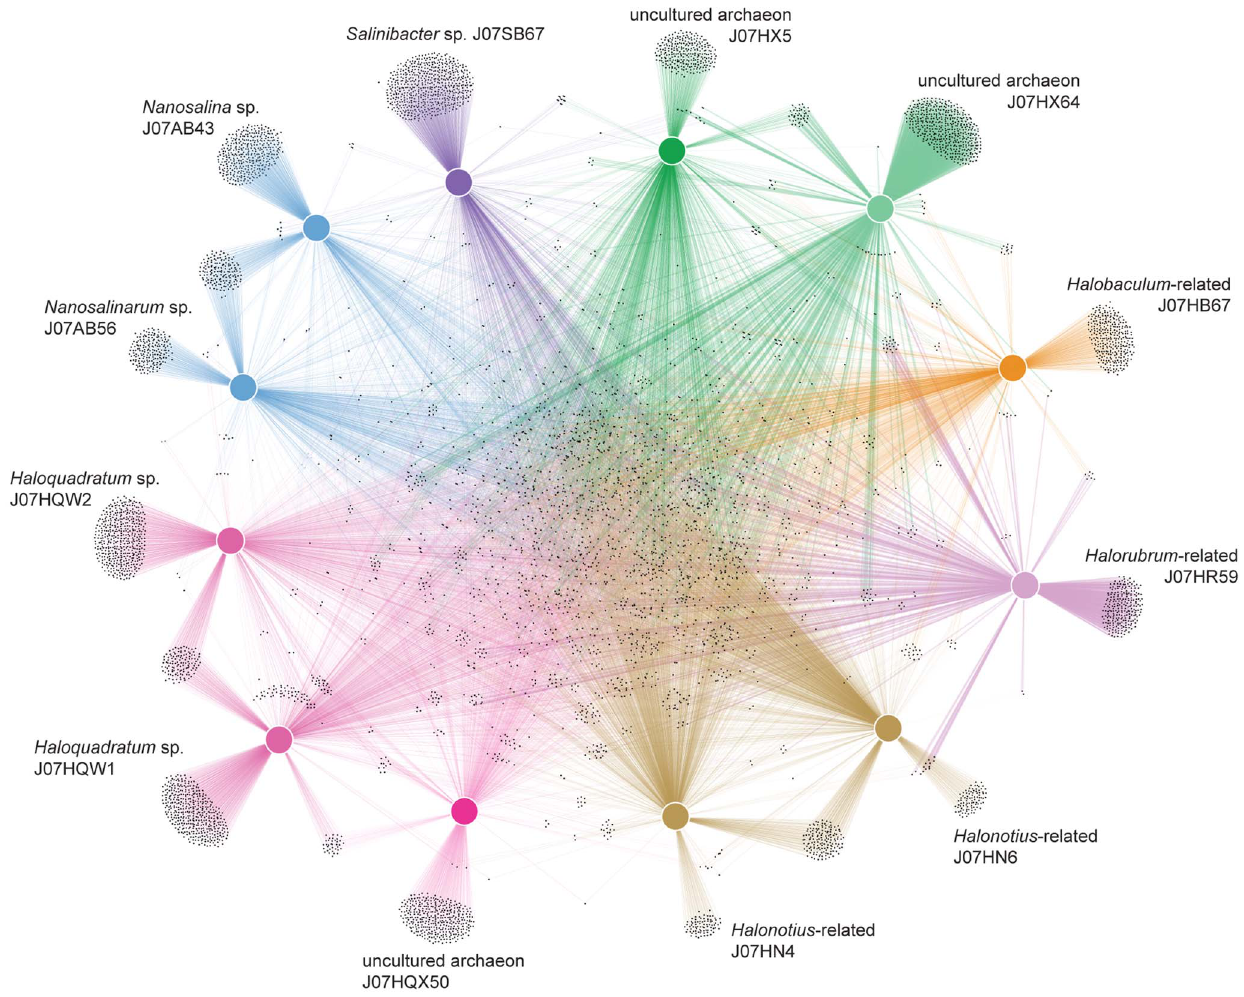
Figure 5. Metabolic connectivity graph showing community distribution of protein family clusters. Cohesive populations are shown as similarly colored nodes and vectors according to numbers of shared features, based on unsupervised protein family clustering of 12 habitat-specific genomes.